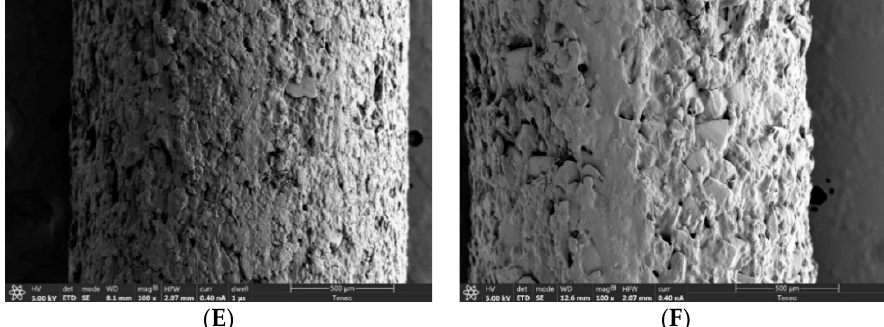
Figure 3. SEM images, magnification 100X, of drug-loaded filaments made with blends containing 5% of both MS and PEG 6000: ( A ) 10A; ( B ) 20A; ( C ) 30A; ( D ) 40A; ( E ) 50A; ( F ) 60A.